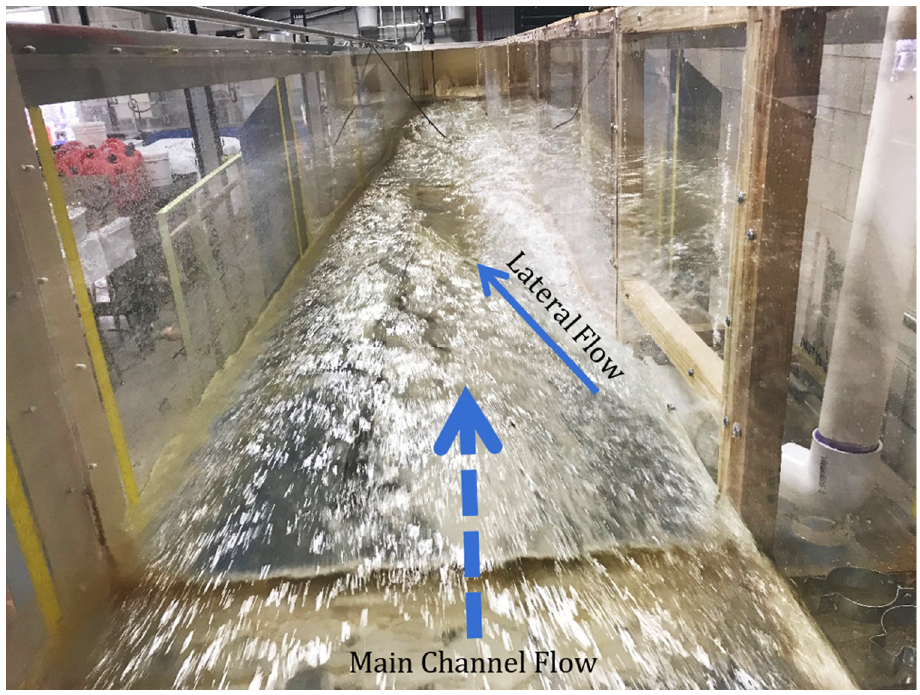
Figure 6. Lateral flow to the main channel (back view). Table 1. Experimental scenarios.